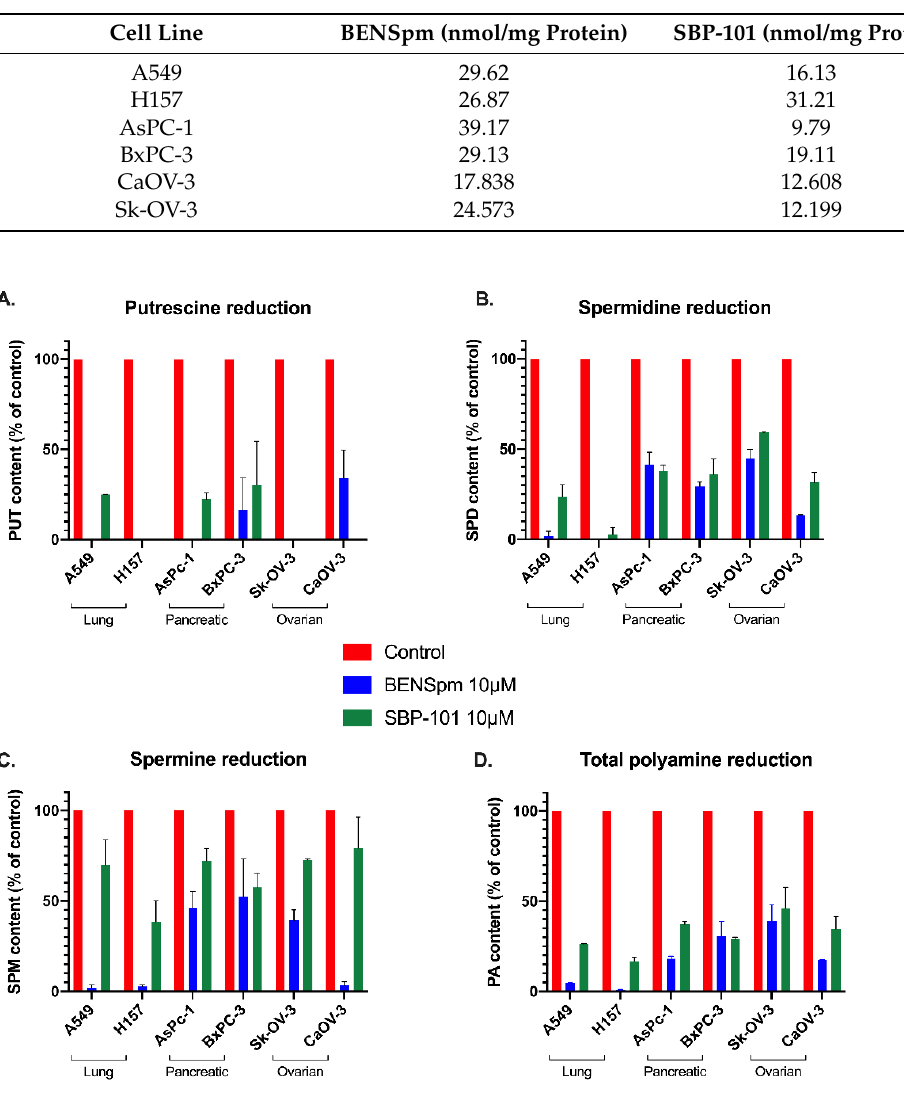
Figure 3. SBP-101 treatment results in a decrease in intracellular polyamine content. Lung, pan- creatic, and ovarian adenocarcinoma lines were treated with 10 µ M of either BENSpm or SBP-101 for 24 h. Cells were then collected and analyzed by HPLC for intracellular polyamine content. Both BENSpm and SBP-101 reduced intracellular putrescine levels to under 25% of original levels in all